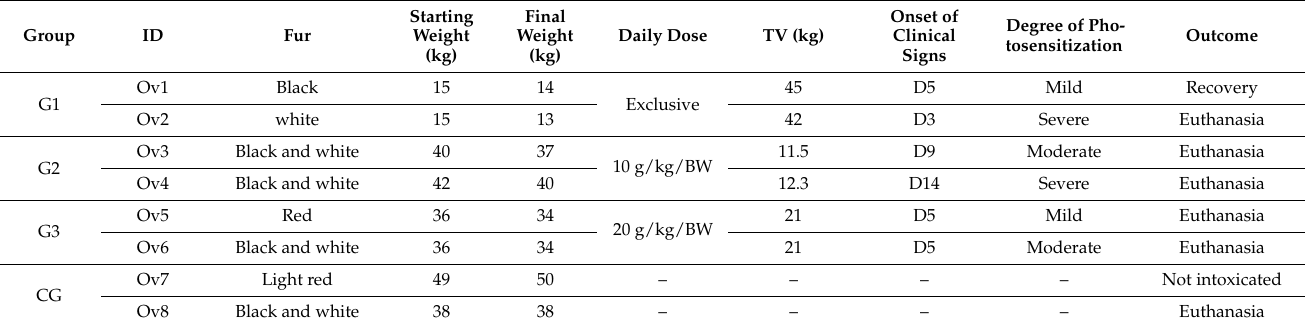
Table 1. Experimental poisoning by Chamaecrista serpens in sheep. Experimental design and outcome.